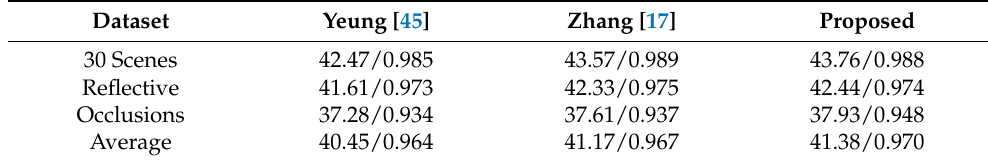
Table 2. Numerical comparison (PSNR/SSIM) of the proposed model for LF reconstruction using the